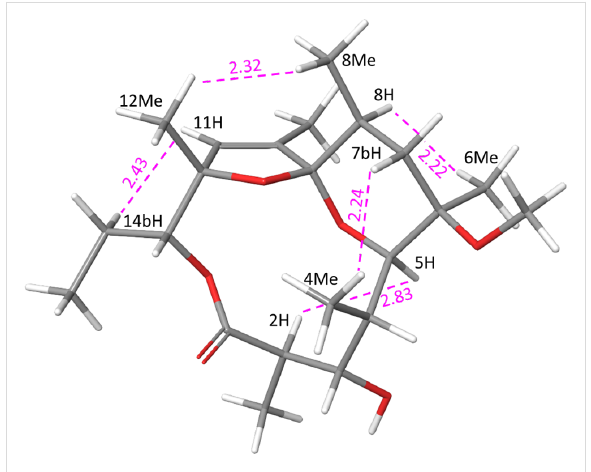
Figure 5: Modelling-derived structure of compound 4 showing key nOe interactions (calculated distances in Å).